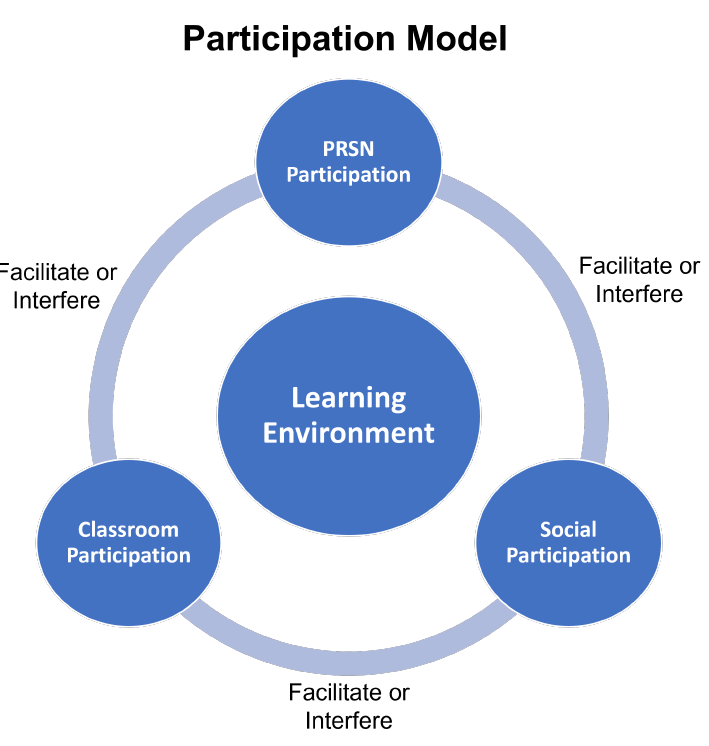
Figure 3. BeingExample participation